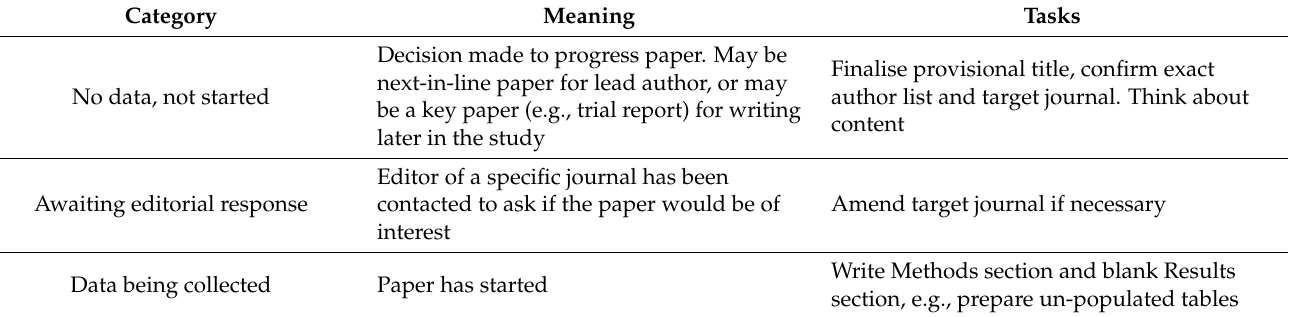
Table 2. Status categories for